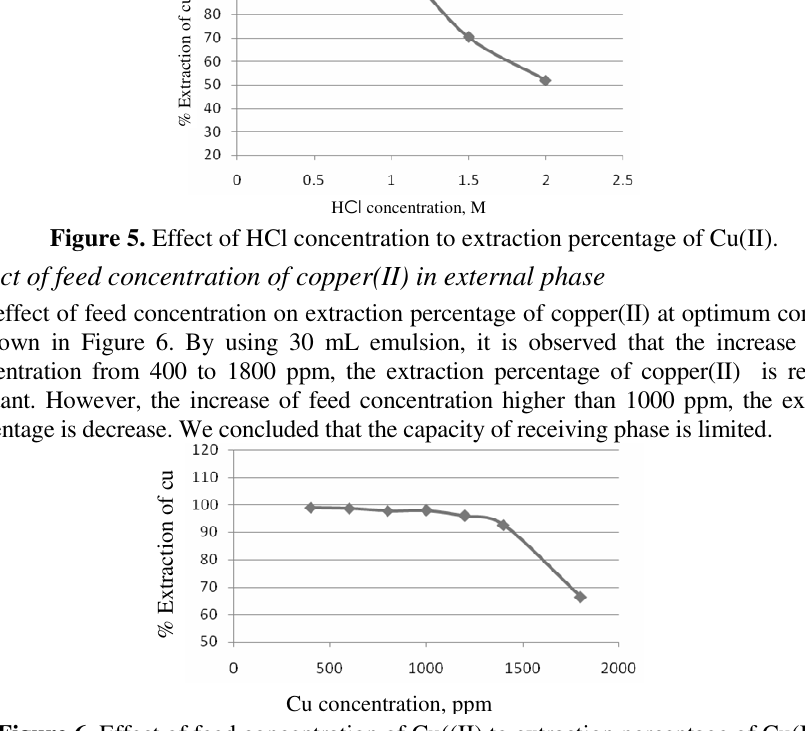
Figure 6. Effect of feed concentration of Cu((II) to extraction percentage of